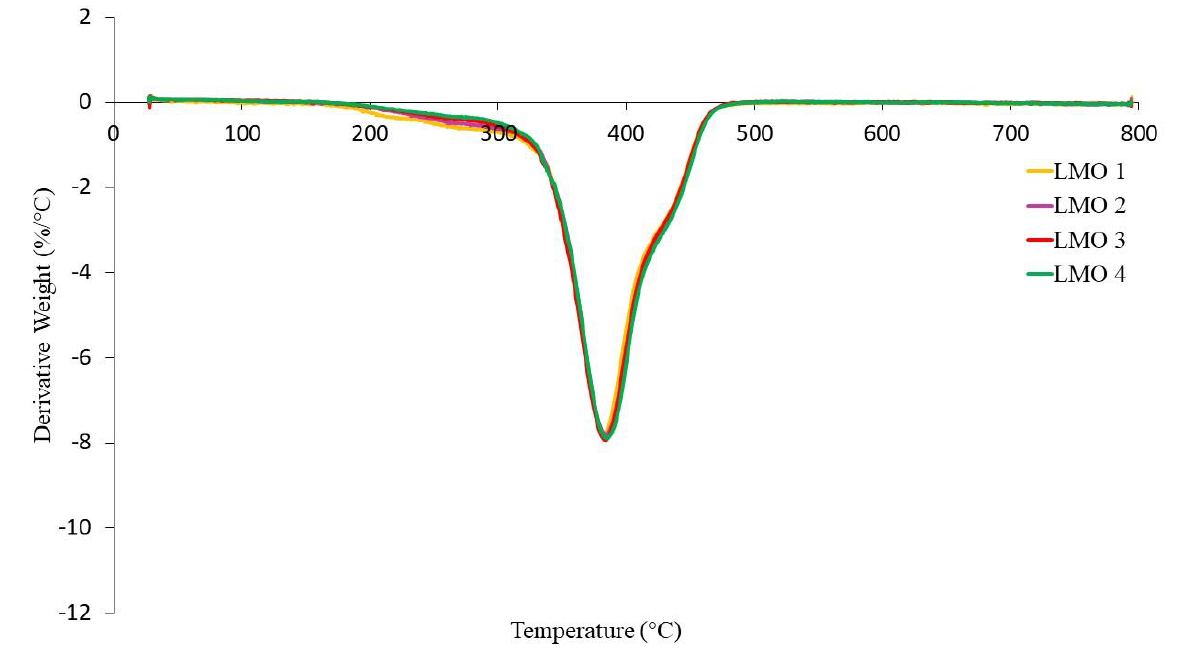
Figure 13. DTG curves of NR-based MREs for different ratios of NO:AO.